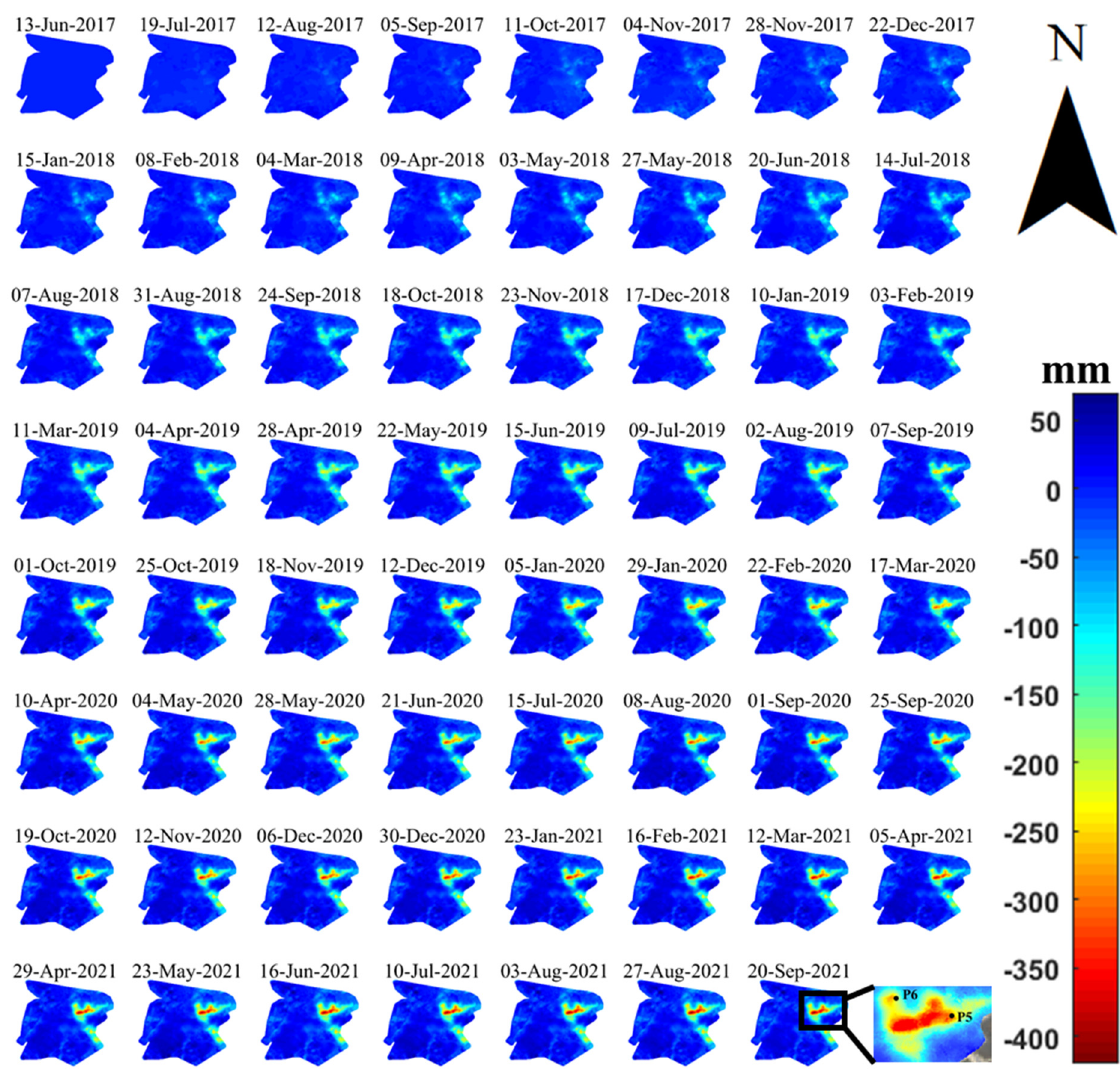
Figure 6. Cumulative vertical deformation time series maps of Xiamen Xiang’an Airport.